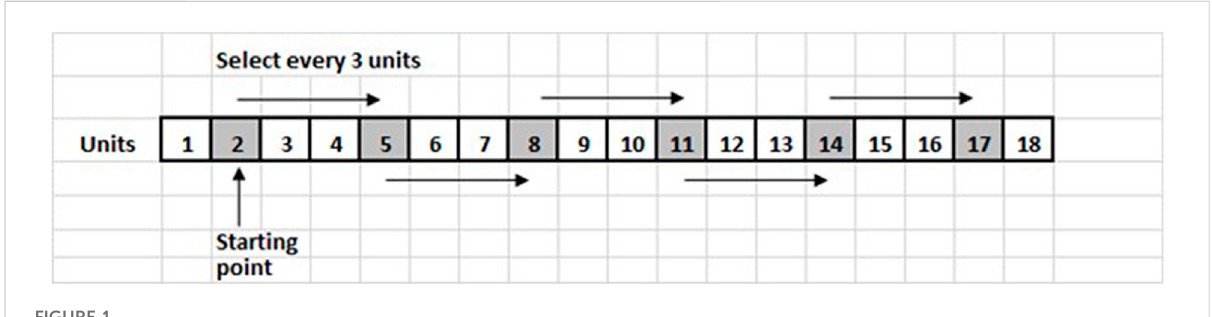
FIGURE 1 Selection of one unit in